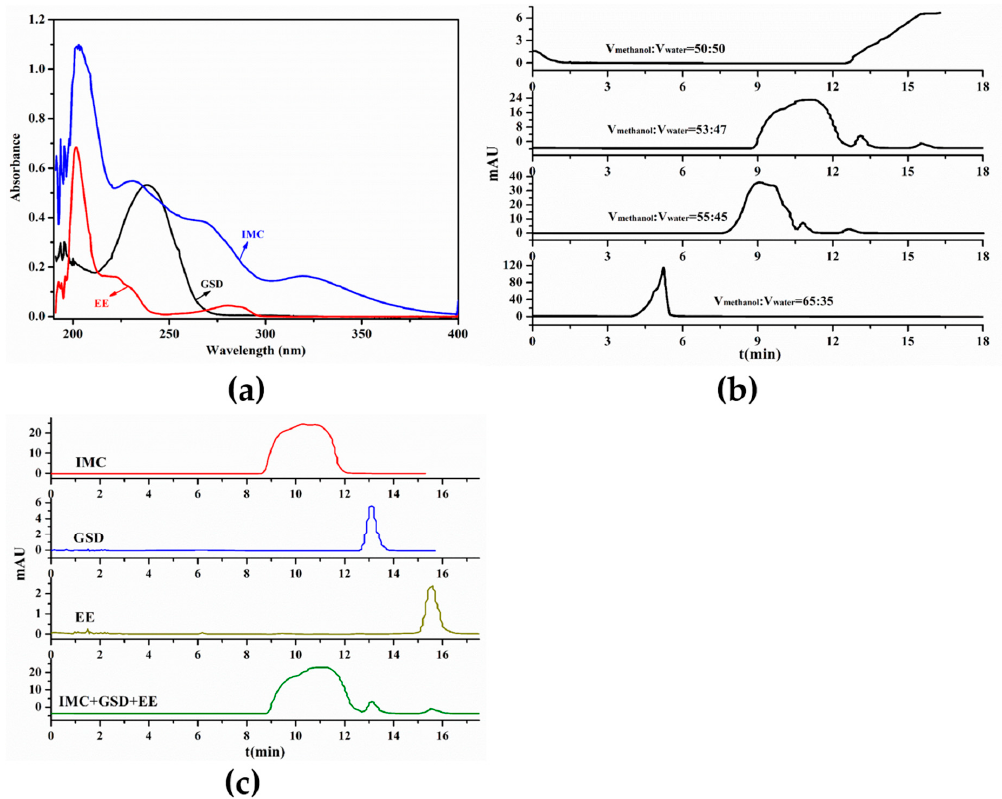
Figure 2. ( a ) The UV-Vis spectra of indomethacin (IMC), gestodene (GSD), and ethinyl estradiol (EE) were recorded using HPLC with a UV-Vis detector from 180 to 400 nm, ( b ) HPLC curves of IMC, GSD and EE in methanol at various mixture ratios of methanol and water, ( c ) HPLC curves of IMC, GSD, EE, and their mixture (methanol/water ratio is 53:47).